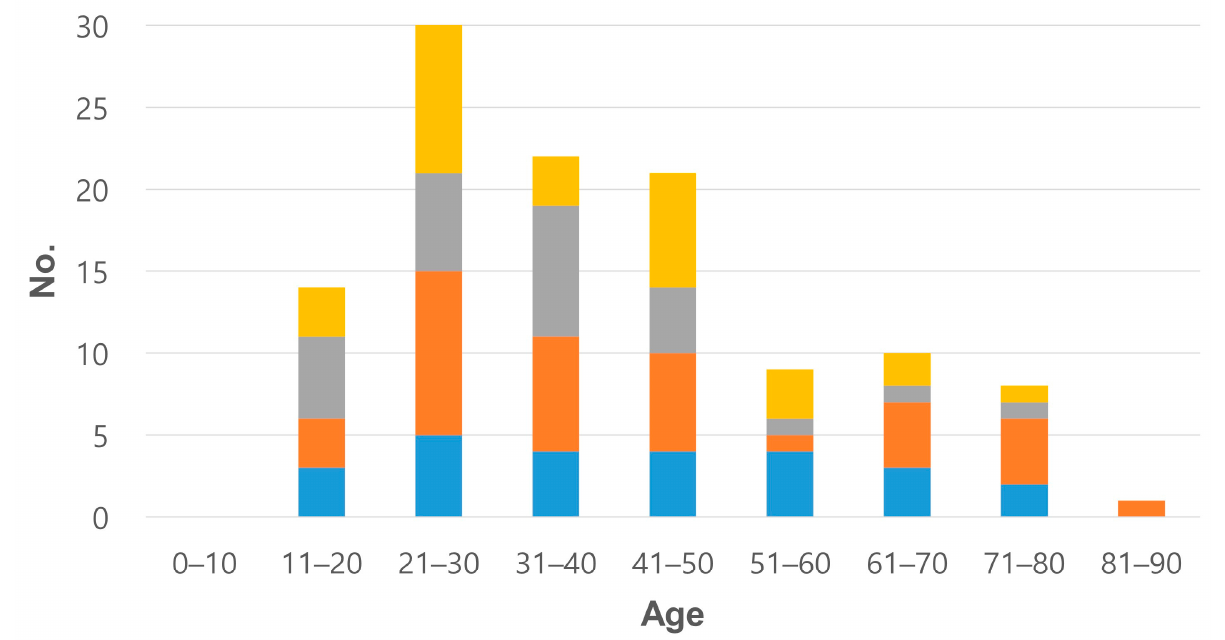
Figure 4. Age and sex distribution before and after 1990 (M, male; F, female). Table 2. Distribution of subtypes.